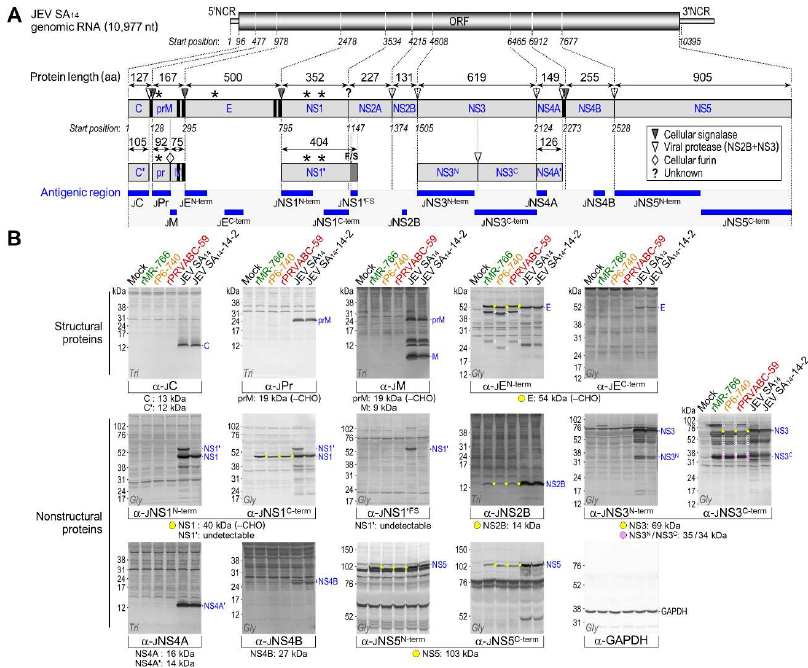
Figure 5. A subset of 15 JEV region-specific polyclonal antibodies detects the cross-reactive ZIKV E, NS1, NS2B, NS3, NS5, and their related species in ZIKV-infected cells. ( A ) Schematic illustration showing the antigenic regions recognized by 15 JEV region-specific rabbit antisera. The 10,977 nt genomic RNA of JEV SA 14 has a 95 nt 5′NCR, a 10,299 nt ORF, and a 583 nt 3′NCR (top panel). The ORF encodes a 3432 aa polyprotein that is processed by viral and cellular proteases into at least 10 mature proteins (middle panel). Marked on the polyprotein are one or two transmembrane domains (vertical black bar) at the C-termini of three structural proteins (C, prM, and E) and at the junction of NS4A/NS4B, as well as four N -glycosylation sites (asterisk) in the pr portion of prM ( 15 NNT), E ( 154 NYS), and NS1 ( 130 NST and 207 NDT). During viral morphogenesis, prM is cleaved by furin protease into a soluble pr peptide and a virion-associated M protein. NS1′ is the product of a −1 ribosomal frameshift (F/S) event that occurs at codons 8–9 of NS2A, adding a 52 aa C-terminal extension to the NS1 protein. The bottom panel displays the antigenic regions (horizontal blue bar) recognized by 15 JEV region-specific rabbit antisera. ( B ) Identification of viral proteins in ZIKV-infected cells by immunoblotting. Vero cells were mock-infected or infected at MOI 1 with each of three ZIKVs (rMR-766, rP6-740, and rPRVABC-59) or two JEVs (SA 14 and SA 14 -14-2, for reference). At 20 h post-infection, total cell lysates were separated by SDS-PAGE on a glycine (Gly) or tricine (Tri) gel and analyzed by immunoblotting with each of the 15 JEV region-specific rabbit antisera or α -GAPDH rabbit antiserum as a loading and transfer control. Molecular size markers are given on the left of each blot, and major JEV proteins for reference are labeled on the right. Provided below each blot are the estimated molecular sizes of the predicted ZIKV proteins, and marked on the blot are the predicted proteins (yellow or pink dot) and presumed cleavage intermediates or further cleavage/degradation products (white circle). CHO, N